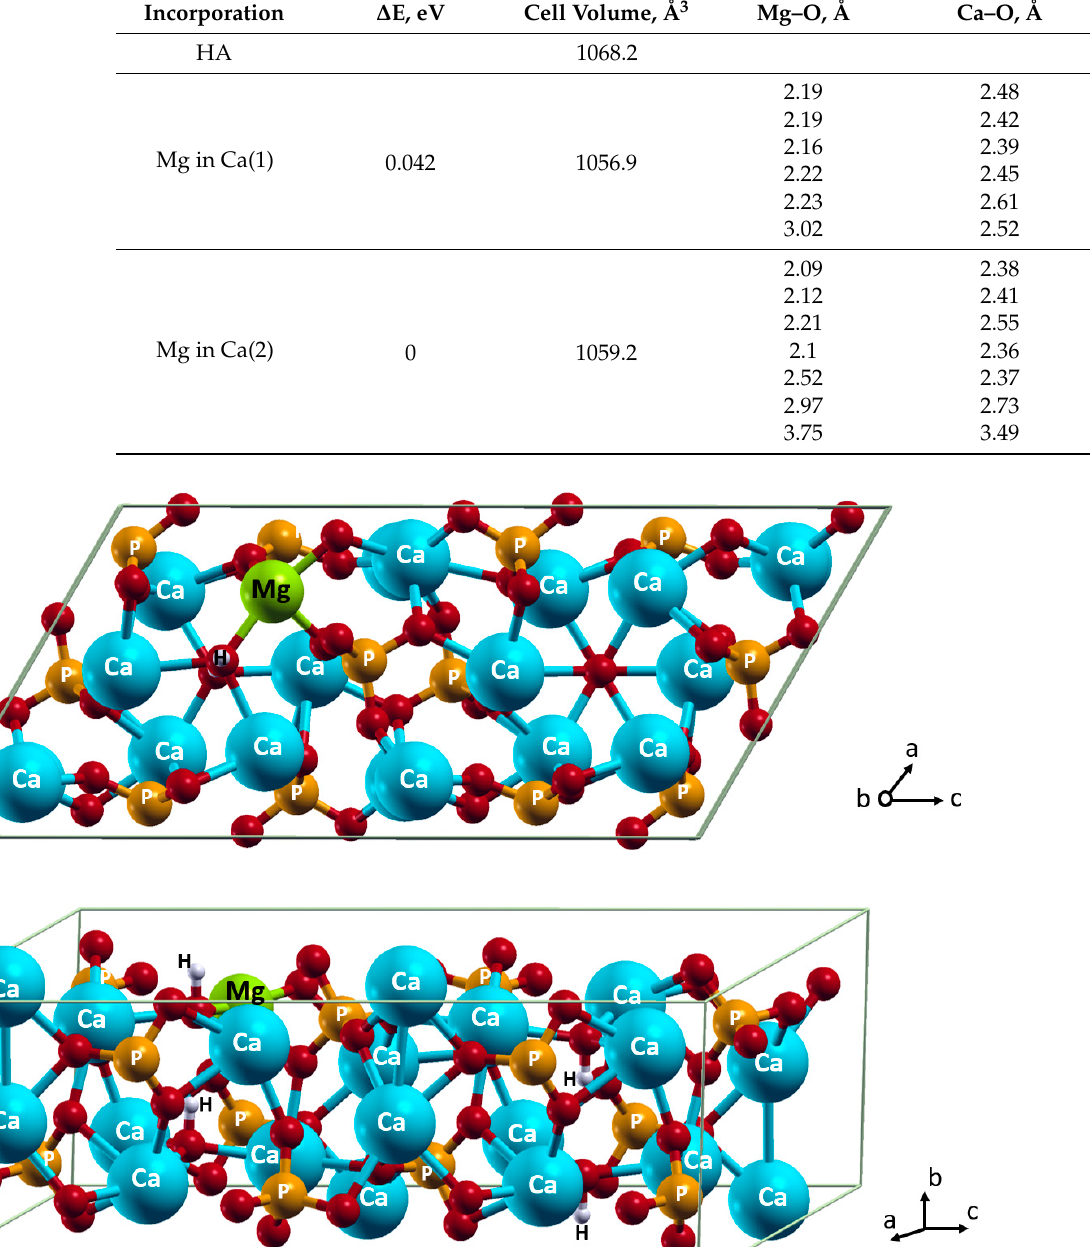
Table 1. Some parameters of the HA cell with formula Ca 10 (PO 4 ) 6 (OH) 2 and the cell with Mg 2+